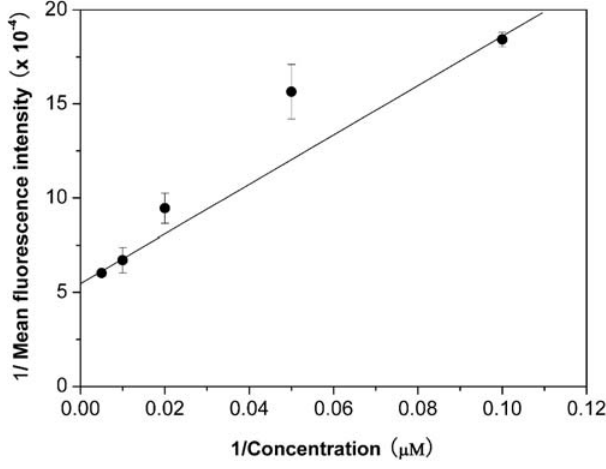
Figure 3. Double-reciprocal plot of the equilibrium binding data. Representative binding data for various concentrations of antigen were expressed as mean fluorescence intensities of triplicates 6 SD.